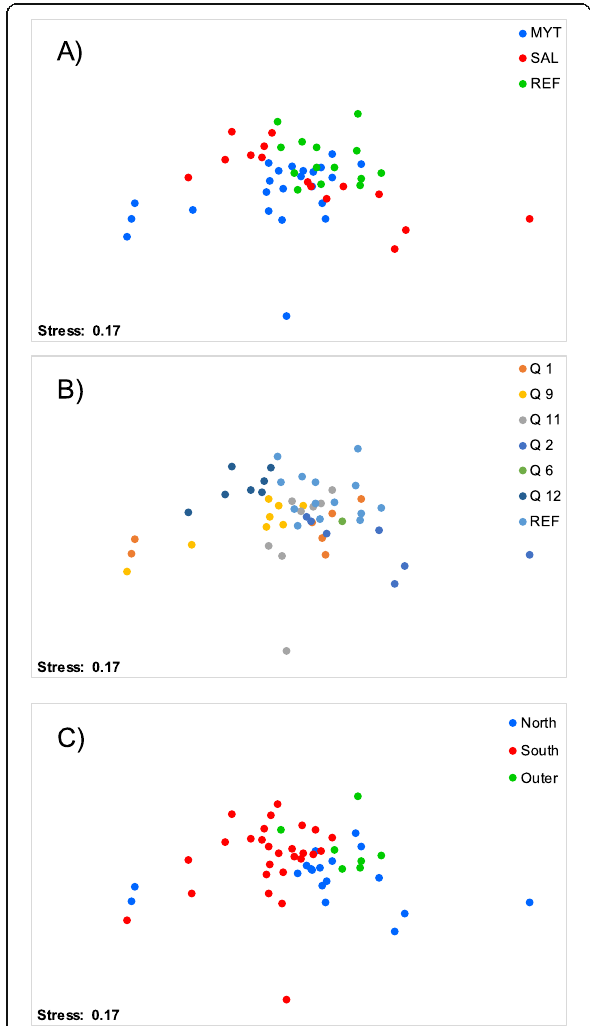
Fig. 5 Output of n MDS for environmental variables in Caucahue Channel. a Different colors represent ENV factor (MYT, SAL, REF sites). b Different colors represent CENTER factor (mussels: Q1, Q9, Q11; salmonids: Q2, Q6, Q12; and reference sites). c Different colors represent the AREA factor (Northern area, Southern area and Outer